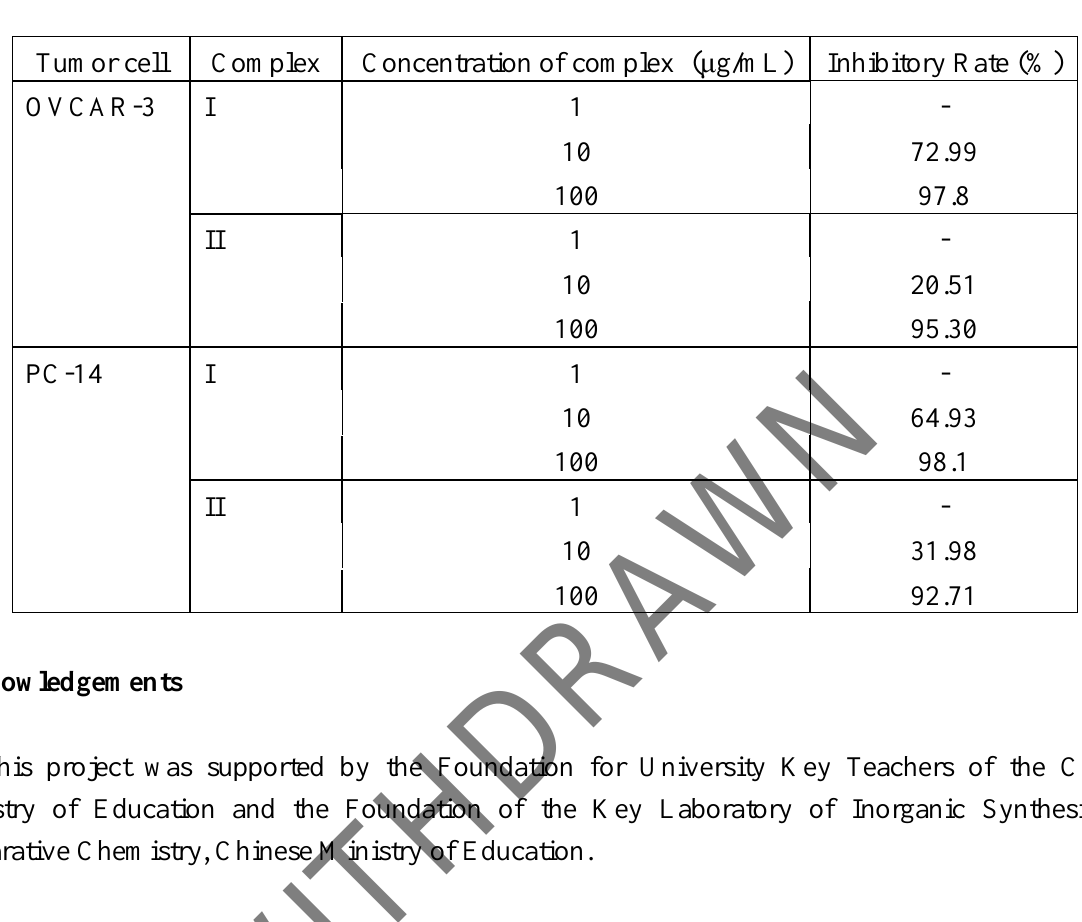
Table 2. Inhibitory effect of the complexes on tumor